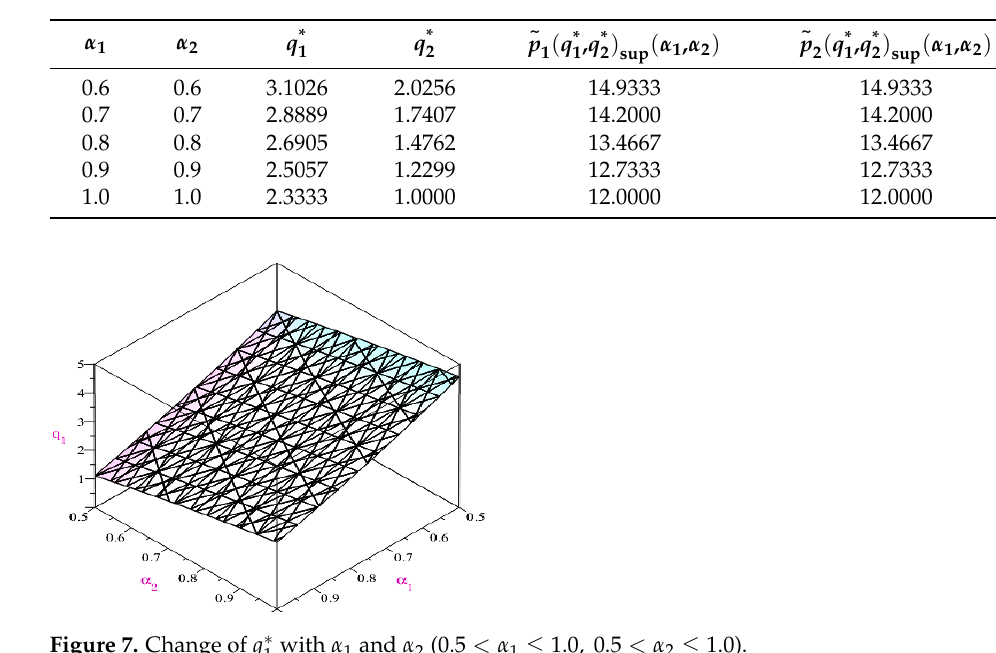
Figure 7. Change of * 1 q with α 1 and α 2 (